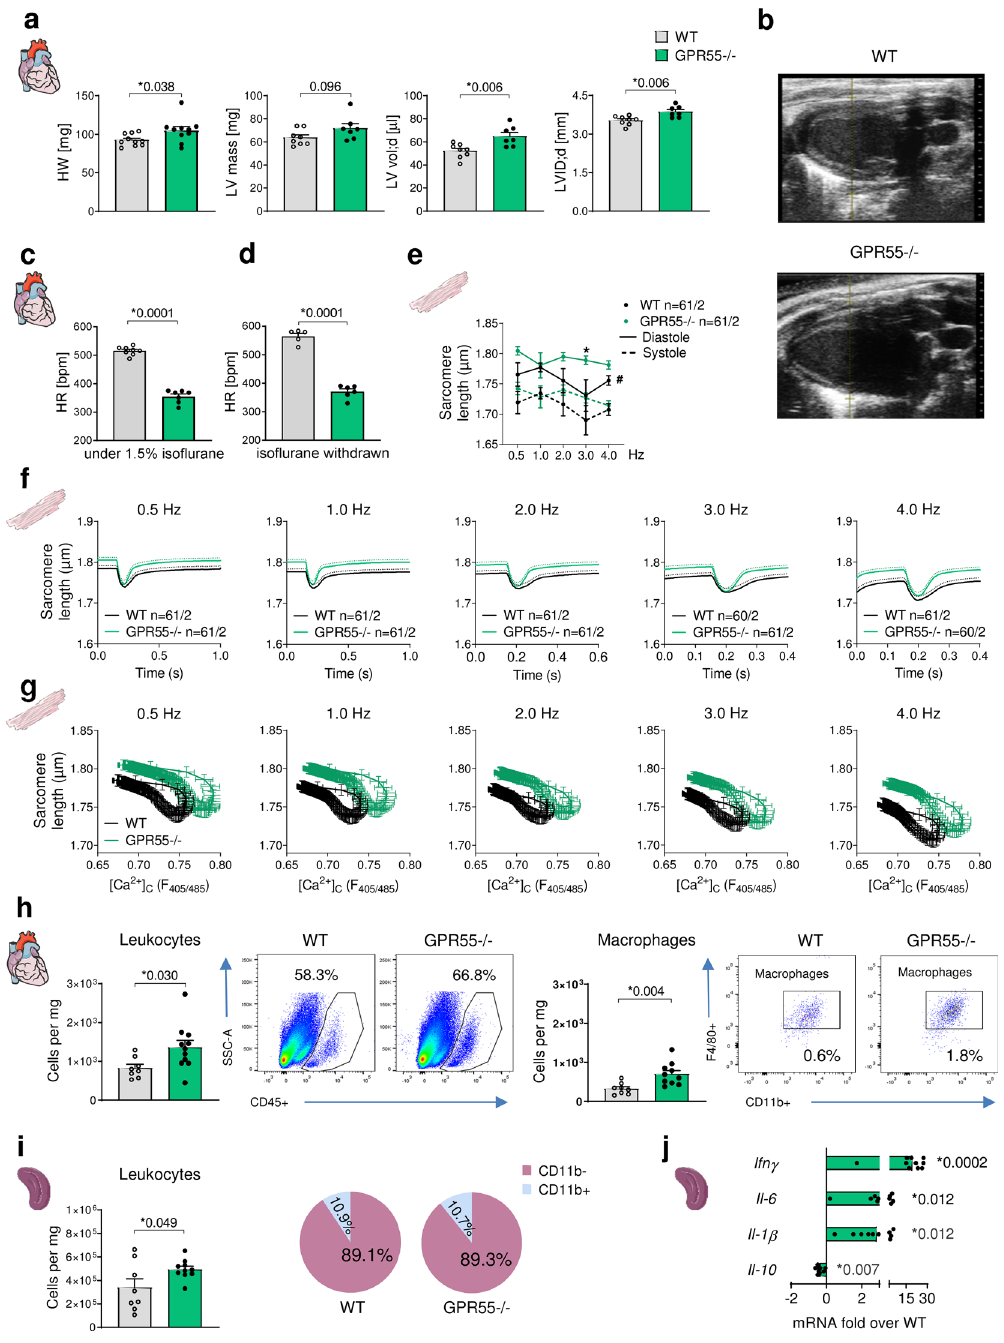
Figure 1. Baseline characterization of GPR55 deficient mice. ( a ) Basal cardiac phenotype of WT and GPR55−/− mice, aged 8 weeks, as determined by gravimetry and echocardiography (n = 8–11/group). ( b ) Representative echocardiographic B-Mode projections of WT and GPR55−/− hearts. Basal heart rate of WT and GPR55−/− mice ( c ) under 1.5% isoflurane inhalation (n = 7–8/group) and ( d ) under conscious conditions upon isoflurane withdrawal (n = 5–6/group). ( e ) Sarcomere length in isolated WT and GPR55−/− cardiomyocytes during diastole (solid lines) and systole (dotted lines) under increasing pacing frequencies. Circles indicate mean ± SE; # p < 0.05, two-way ANOVA with Bonferroni’s post hoc test (*p < 0.05 vs. WT); n indicates number of isolated cardiomyocytes from 2 mice. ( f ) Sarcomere length recordings from isolated WT and GPR55−/− cardiomyocytes under increasing pacing frequencies over time. Solid lines indicate mean + SE (dotted line). ( g ) Ca 2+ dependent sarcomere length in WT and GPR55−/− cardiomyocytes. ( h ) Basal LV leukocyte counts and herein macrophage numbers in WT and GPR55−/− mice detected via flow cytometry, and representative dot plots indicating respective leukocyte (CD45+) and macrophage (CD11b+ F4/80+) counts as percentage of single cells (n = 8–12/group). ( i ) Basal splenic leukocyte counts and relative distribution of myeloid (CD11b+) and lymphoid (CD11b-) cells in WT and GPR55−/− mice detected via flow cytometry (n = 8–12/group). ( j ) Basal splenic chemokine gene expression in GPR55−/− mice as fold over WT (n = 8–12/ group). Bars and squares indicate mean ± SE (Comparison between two groups: Student’s